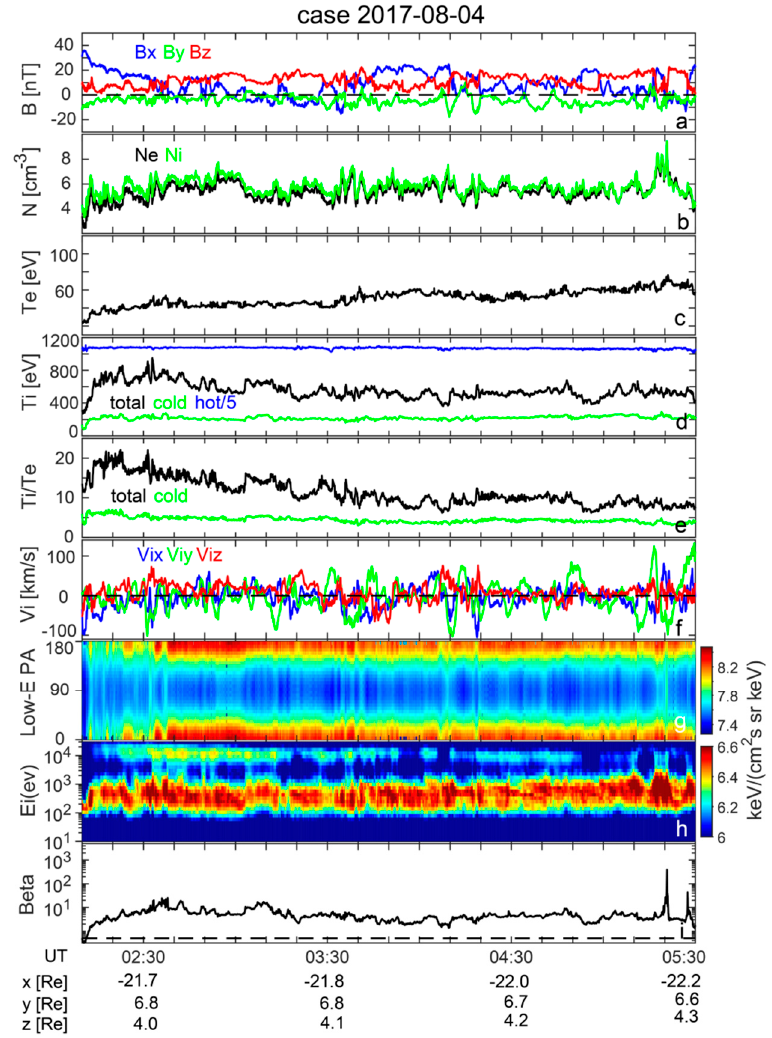
Figure 5. MMS1 observations of a CDPS on 4 August 2017.The figure is in the same format as Figure 2.